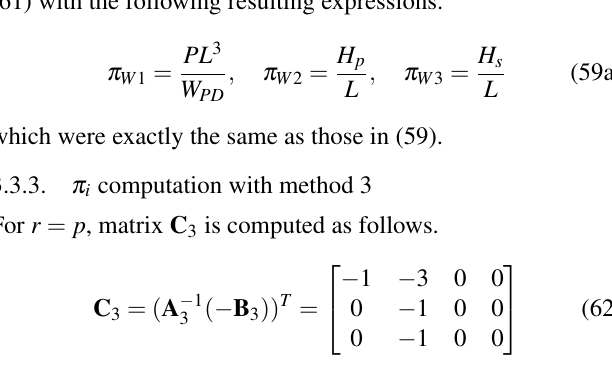
Table 4. Application of Gauss-Jordan elimination in the DA for the PD